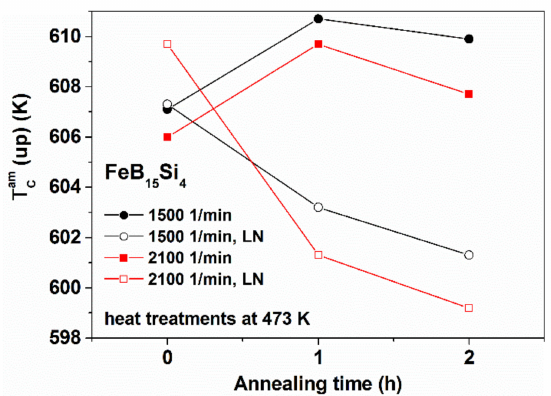
Figure 21. Change of the Curie temperature T Cam for FeSi 4 B 15 samples during a series of measuring runs. Adapted from [97], with permission from Springer Nature,